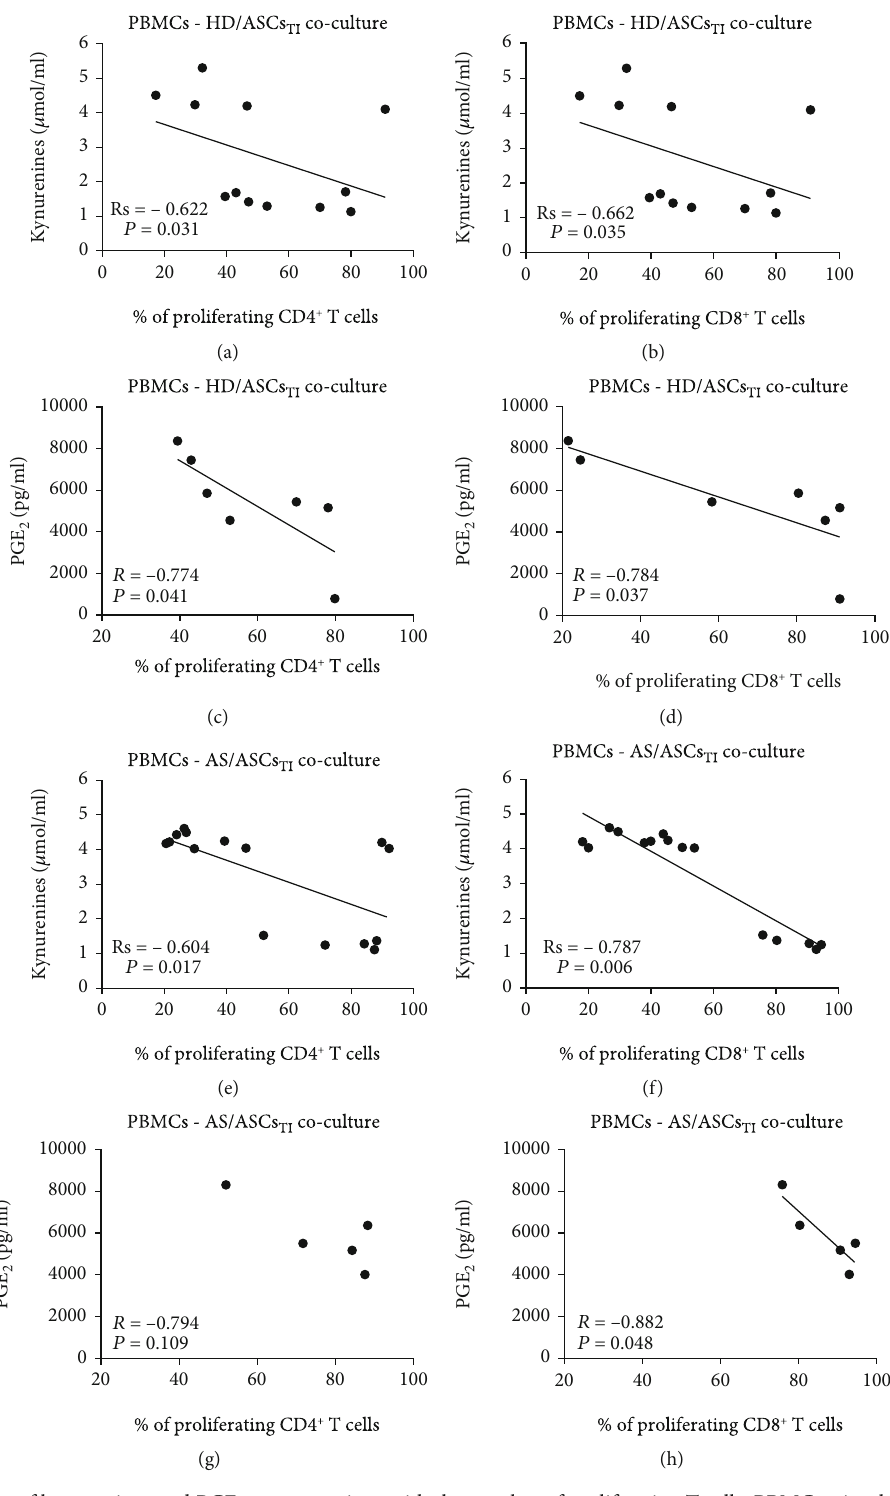
Figure 5: Correlation of kynurenines and PGE concentrations with the number of proliferating T cells. PBMCs stimulated with PHA were 2 cocultured with TNF +IFN γ - (TI-) treated ASCs from HD (a – d) and AS patients (e – h). The proliferation of CD4 + (a, c, e, g) and CD8 + (b, d, f, h) cells was evaluated, and the measurement of kynurenines and PGE concentrations was performed as described in Materials 2 and Methods. Spearman ’ s rank ( Rs ) (a, b, e, f) and Pearson ’ s ( R ) (c, d, g, h) correlation coe ffi cients and P values are shown. Other explanations as in Figure